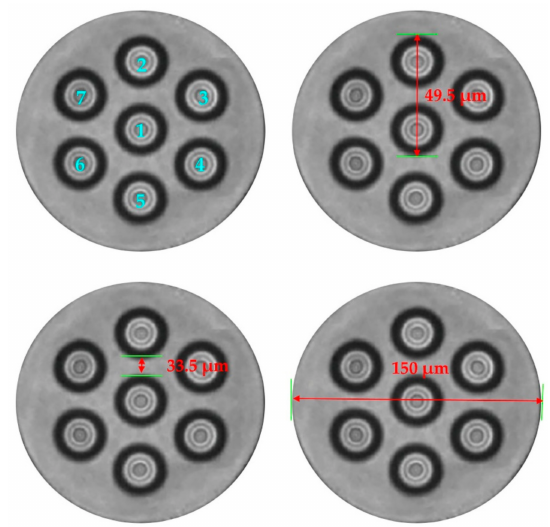
Figure 5. Cross section of